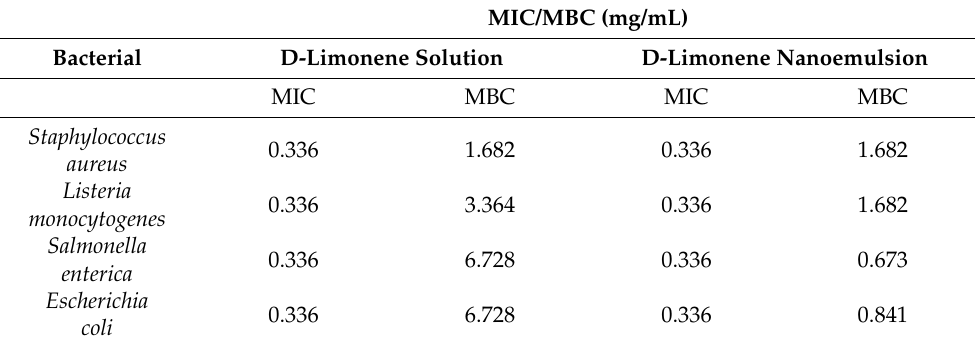
Table 3. Values of MIC and MBC concentrations of D-limonene solution and D-limonene nanoemul- sion against food-borne pathogens using broth dilution